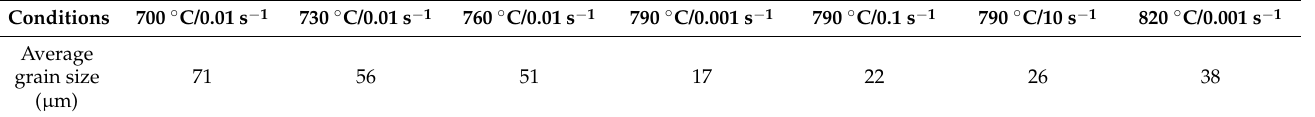
Table 5. Average grain size.